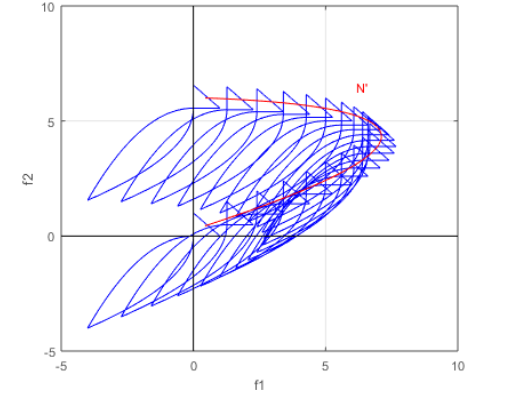
Figure 5. Nash trajectory N (cid:48) : z → N (cid:48) ( z ) = ( 4/9,4/9 ) + µ ( z , z 2 ) .